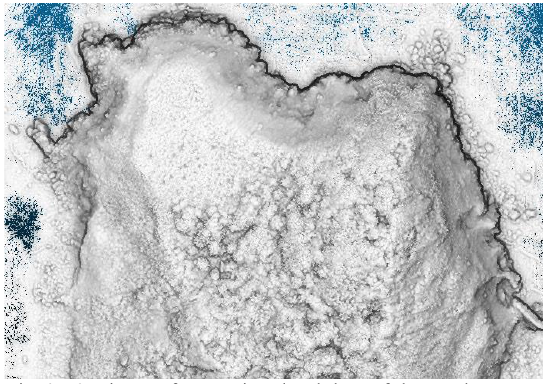
Fig.6 3D image from Point cloud data of the northernmost terrain of Orono-shima